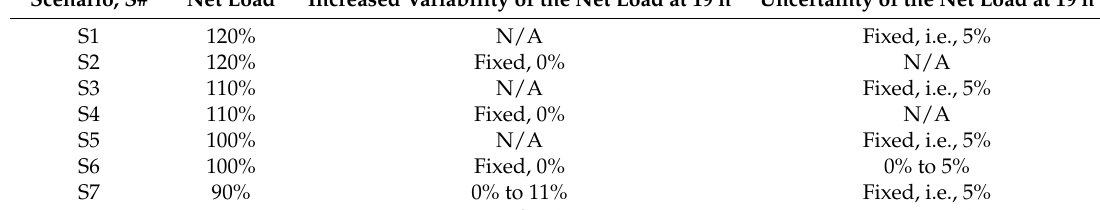
Table 3. Allowed ranges of increased variability and uncertainty. ※ N/A : not allowed.